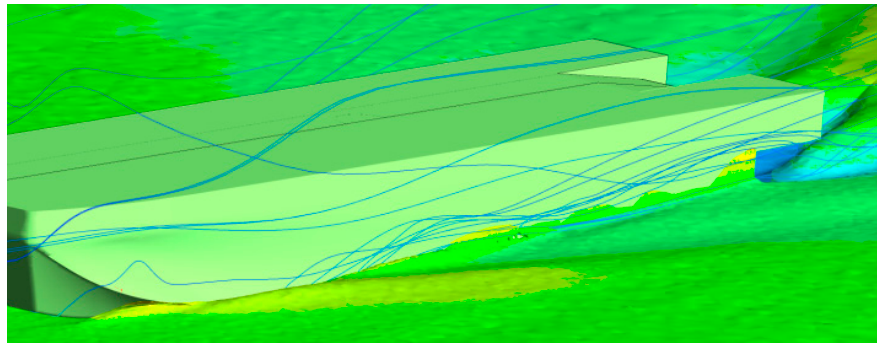
Figure 15. Comparison of numerical and experiment free surface wave making ( Fr = 1.03).